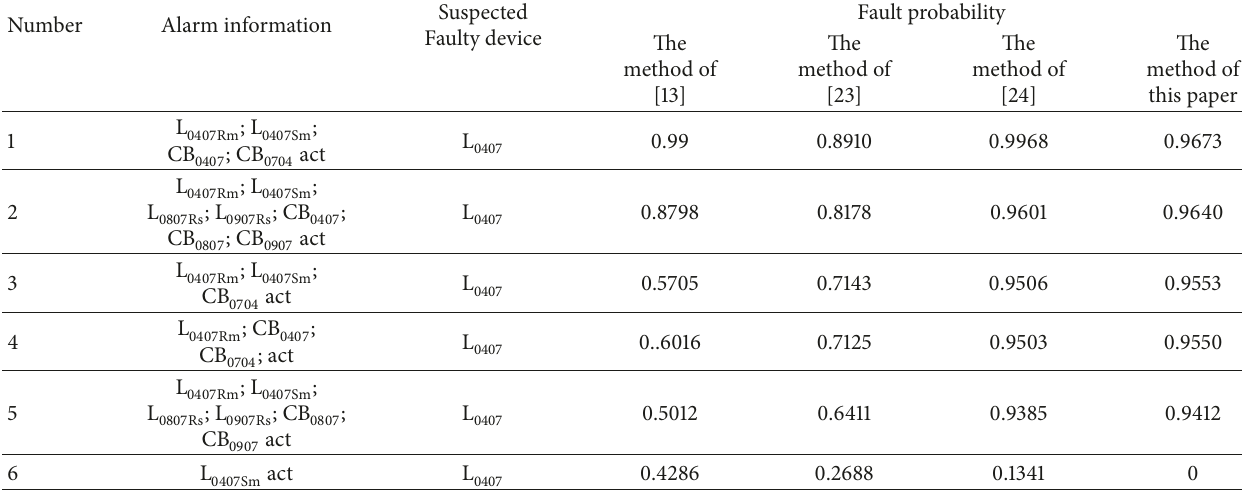
Table 2: Comparison of the diagnostic results under the same